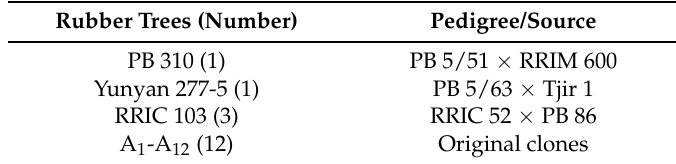
Table 1. Plant materials used as candidate male parents of GT1’s triploid